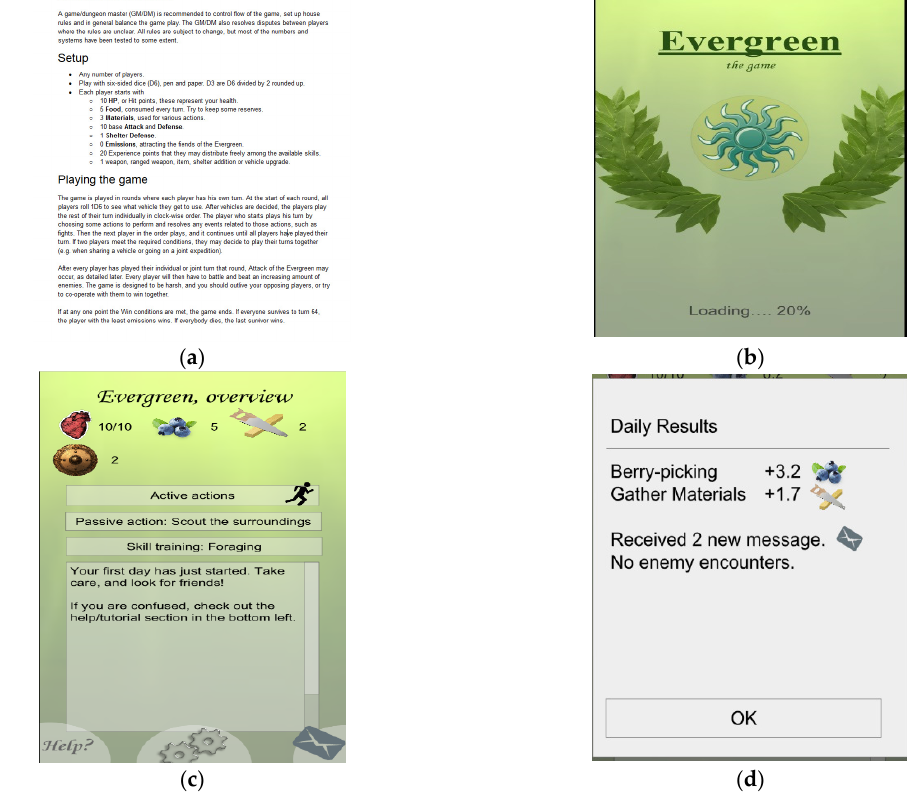
Figure 8. Early design stages of the Evergreen persuasive game. ( a ) First page of the initial paper prototype (11 pages in total) [51]. ( b ) Early design of the game’s splash screen. ( c ) Early design of the game’s main screen showing player statistics in the top, buttons for actions, and a log of what has happened previously. ( d ) Early design of the results screen, which is displayed after each new day.